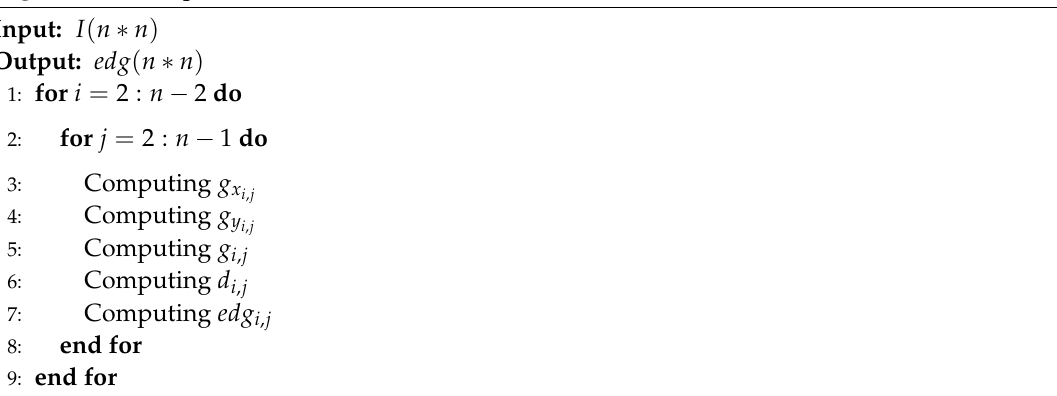
Algorithm 1 The pseudo code of